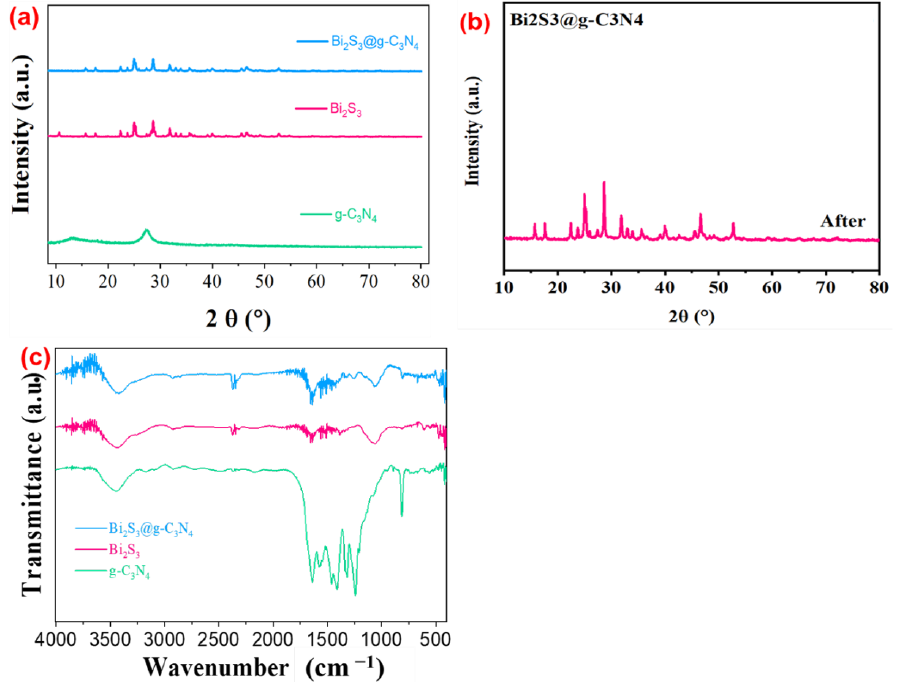
Figure 3. XRD and FTIR analysis results. ( a ) The XRD patterns of the synthesized Bi 2 S 3 @g-C 3 N 4 , Bi 2 S 3 , and g-C 3 N 4 before the photocatalytic test. ( b ) The XRD analysis of the synthesized Bi 2 S 3 @g- C 3 N 4 after the photocatalytic test and the ( c ) FTIR spectra analysis of the prepared Bi 2 S 3 @g-C 3 N 4 , Bi 2 S 3 , and g-C 3 N 4 .